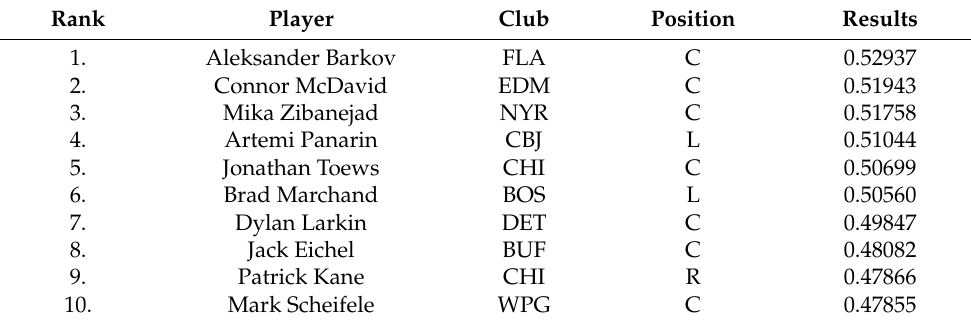
Table 5. Ten best players as evaluated by the CRITIC–TOPSIS